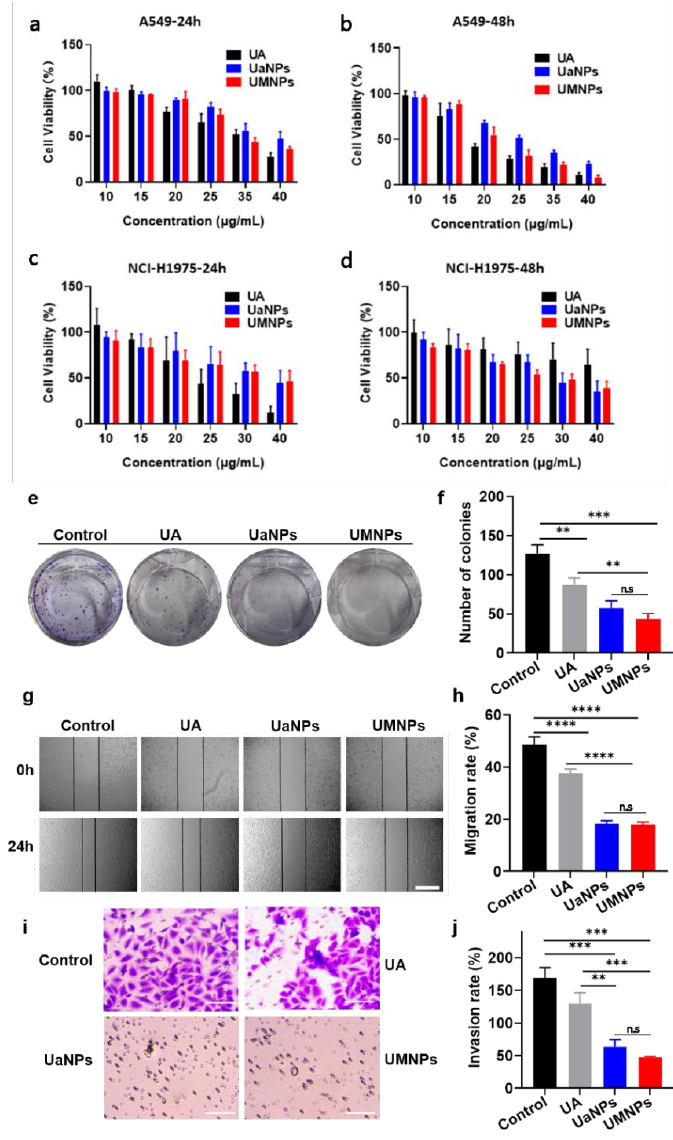
Figure 3. In vitro cytotoxicity of UA, UaNPs, and UMNPs: ( a , b ) Cell survival of A549 cells after treatment with different concentrations of free UA, UaNPs, and UMNPs for 24 h and 48 h, respectively; ( c , d ) Cell survival of NCI-H1975 cells after treatment with different concentrations of free UA, UaNPs, and UMNPs for 24 h and 48 h, respectively; ( e , f ) Cloning formation assay of free UA, UaNPs, and UMNPs in A549 cells; ( g , h ) Cell migration assay of free UA, UaNPs, and UMNPs in A549 cells. Scale bar = 200 μm; ( i , j ) Transwell invasion assay of free UA, UaNPs, and UMNPs in A549 cells. Scale bar = 100 μm. Differences were considered significant when * p < 0.05, ** p < 0.01, or *** p < 0.001, **** p < 0.0001, Respectively, while there is no significant when p ＞ 0.05 which means ns.